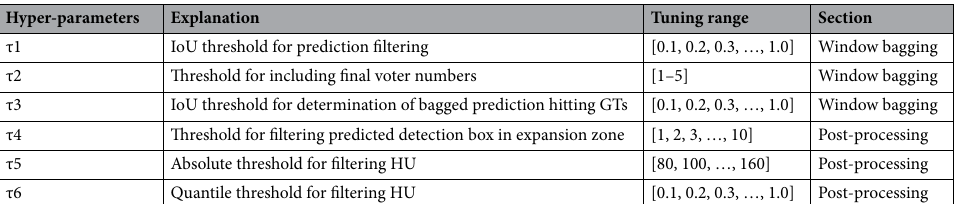
Table 3. Tunable hyper-parameters elaboration for the paragraphs of prediction post-processing and “bagging” in Sect. 2.2.2.